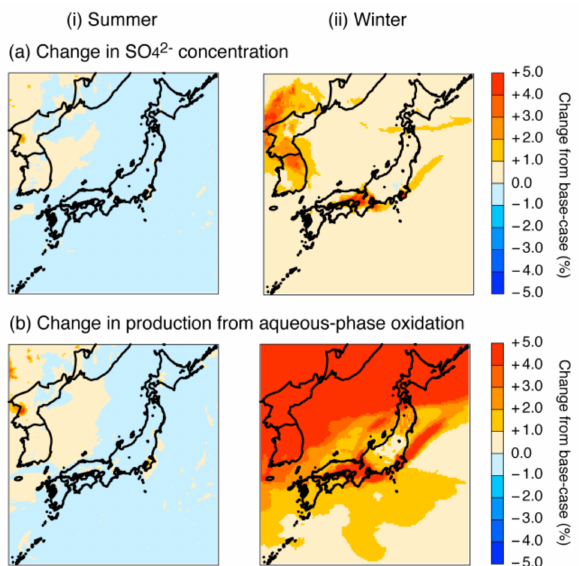
Figure 7. Changes in ( a ) SO 42 − concentration and ( b ) production from aqueous-phase oxidation averaged over ( i ) summer and ( ii ) winter. Model results from sensitivity simulation B are compared with the base-case